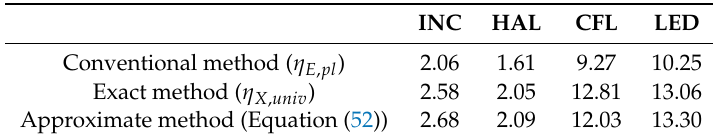
Table 9. Valuableexergeticefficiencies(in%)foreachofthethreemethods(conventional,exact,and approximate) and each of the four example lamps (INC, HAL, CFL, LED). Note that the conventional method row is the same as row 3 of Table 4. The exact method row is the same as row 4 of Table 6. The